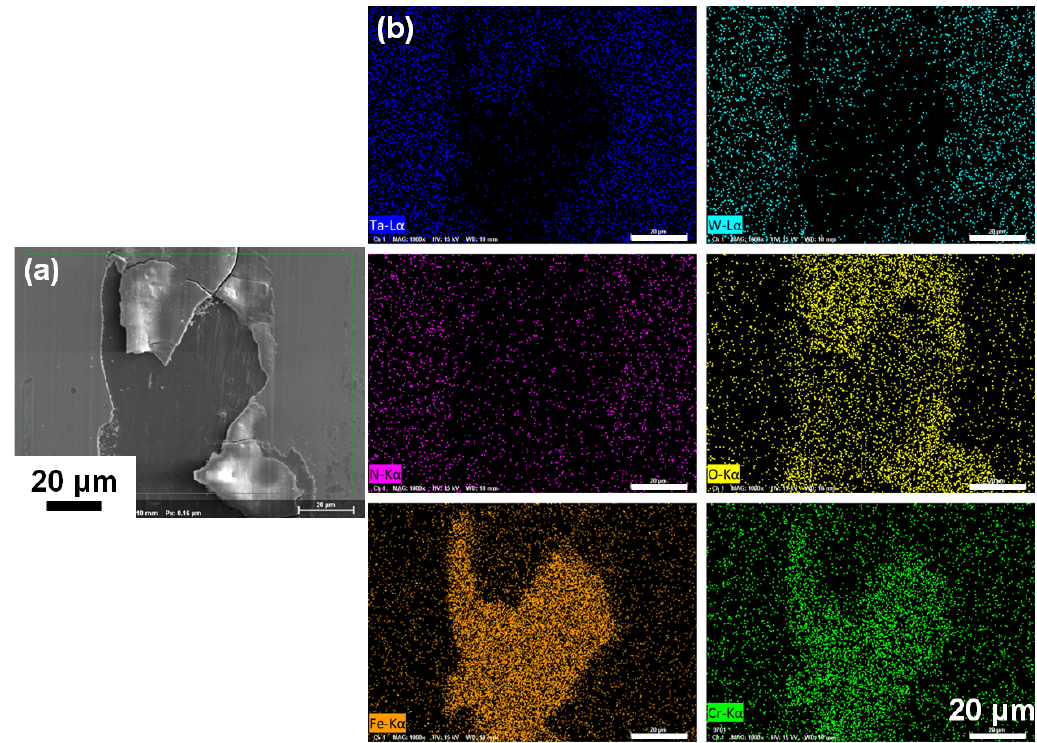
Figure 11. ( a ) SEM image and ( b ) elemental mappings of the Ta 40 W 15 N 45 film after the wear test.